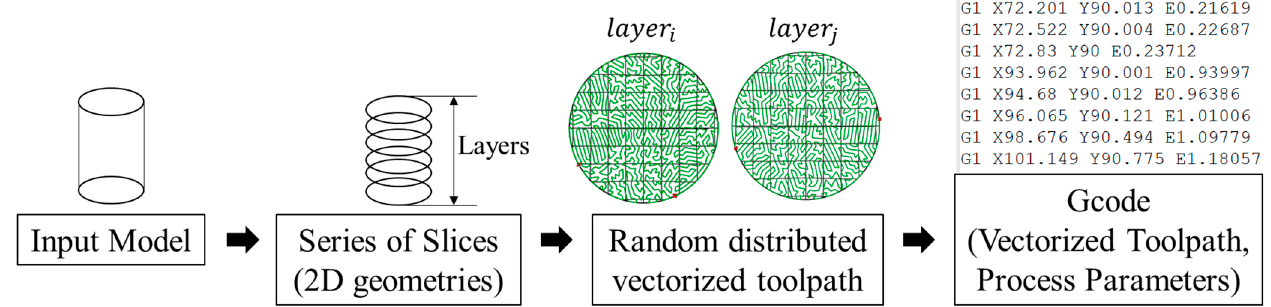
Figure 3. Workflow of generating in-plane isotropy toolpath.